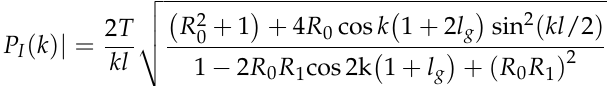
pressure. under different sound